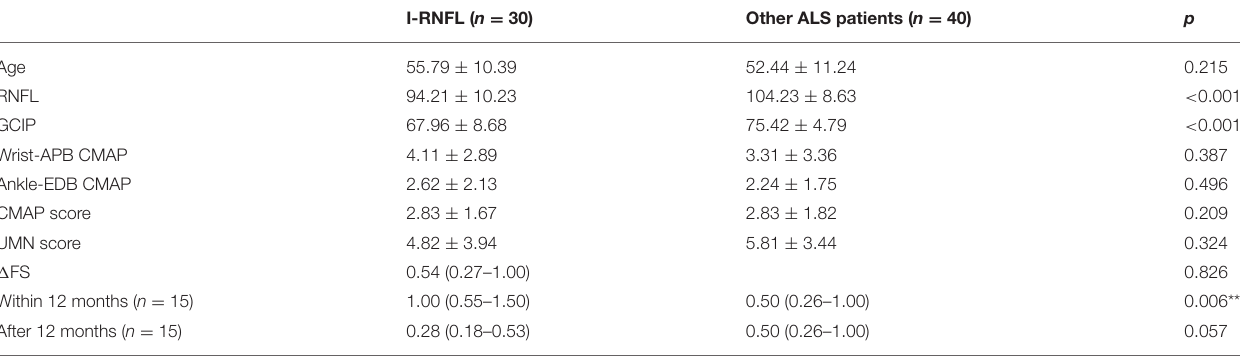
RNFL, retinal nerve fiber layer; GCIP, ganglion cell/inner plexiform; APB, abductor pollicis brevis; EDB, extensor digitorum brevis; CMAP, compound muscle action potential; UMN, upper motor neuron; 1 FS, 48-(ALSFRS-R assessment)/symptom duration (months). ** p ≤ 0.01, *** p <